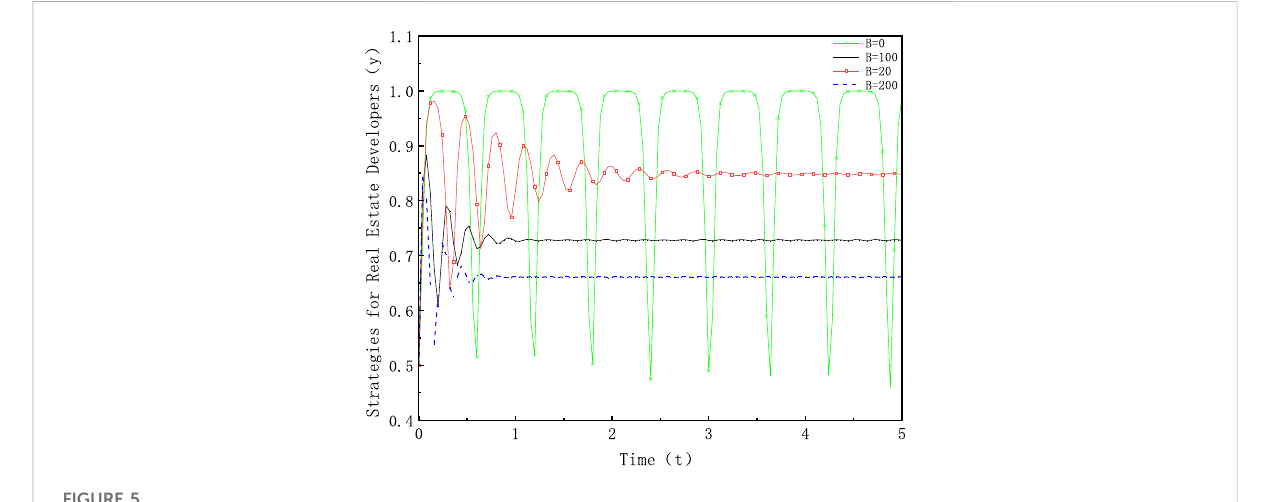
FIGURE 5 Strategies evolution of property developers under different subsidies.